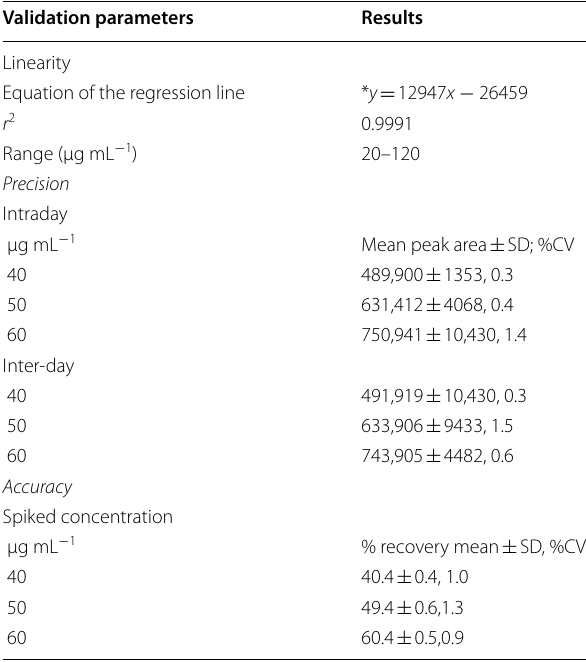
Table 3 Summary of HPLC method validation